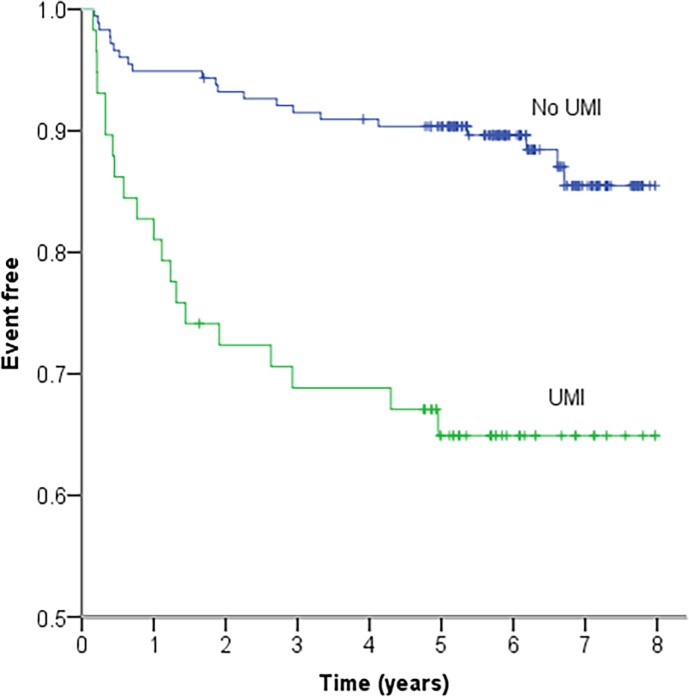
Kaplan-Meier plot of the cumulative probability of remaining event free for patients with UMI versus patients without UMI.P<0.001. Blue line = No UMI. Green line = UMI.